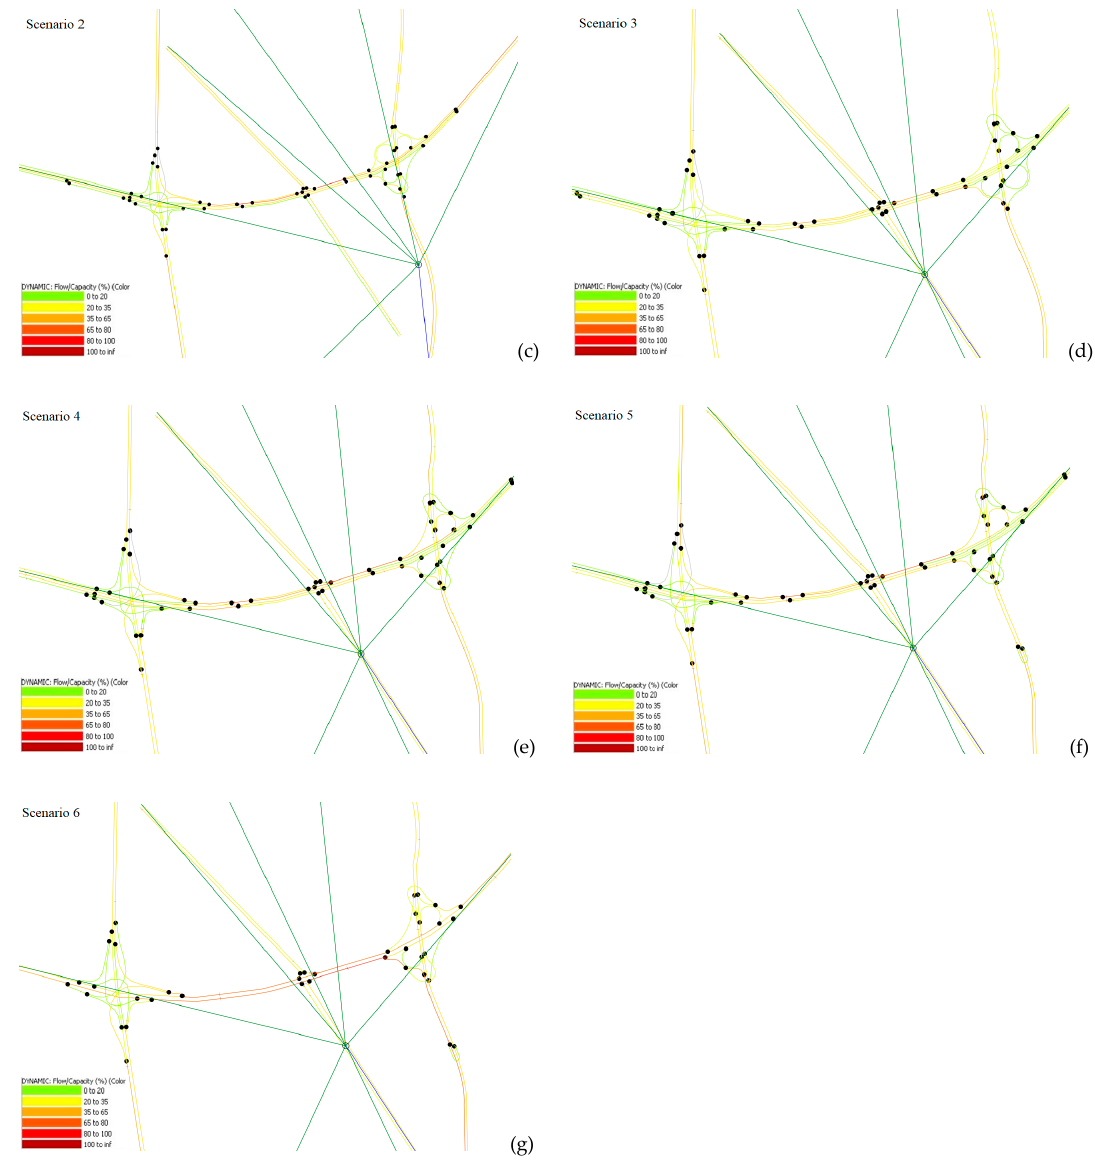
Figure 3. Simulation of the current transportation network and flow per capacity (F/C) ratio for the present situation ( a ), scenario 1 ( b ), scenario 2 ( c ), scenario 3 ( d ), scenario 4 ( e ), scenario 5 ( f ), and scenario 6 ( g ).